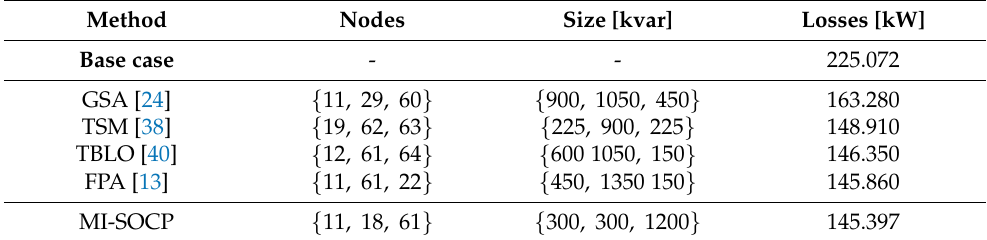
Table 4. Optimal location of capacitor banks in the IEEE 69-node test feeder.